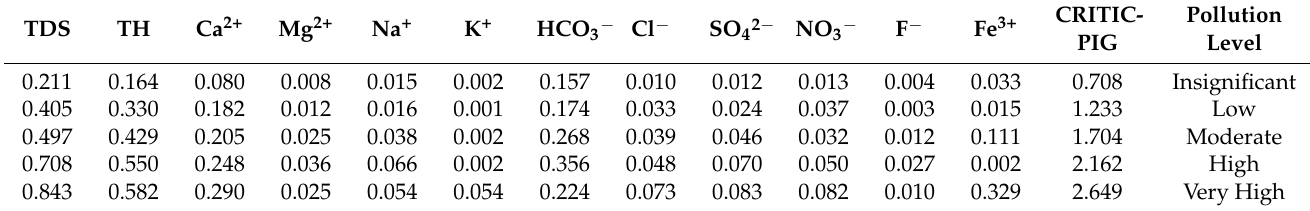
Table 8. Average values of the overall water quality of each chosen parameter in five pollution-level zones obtained using the CRITIC-PIG